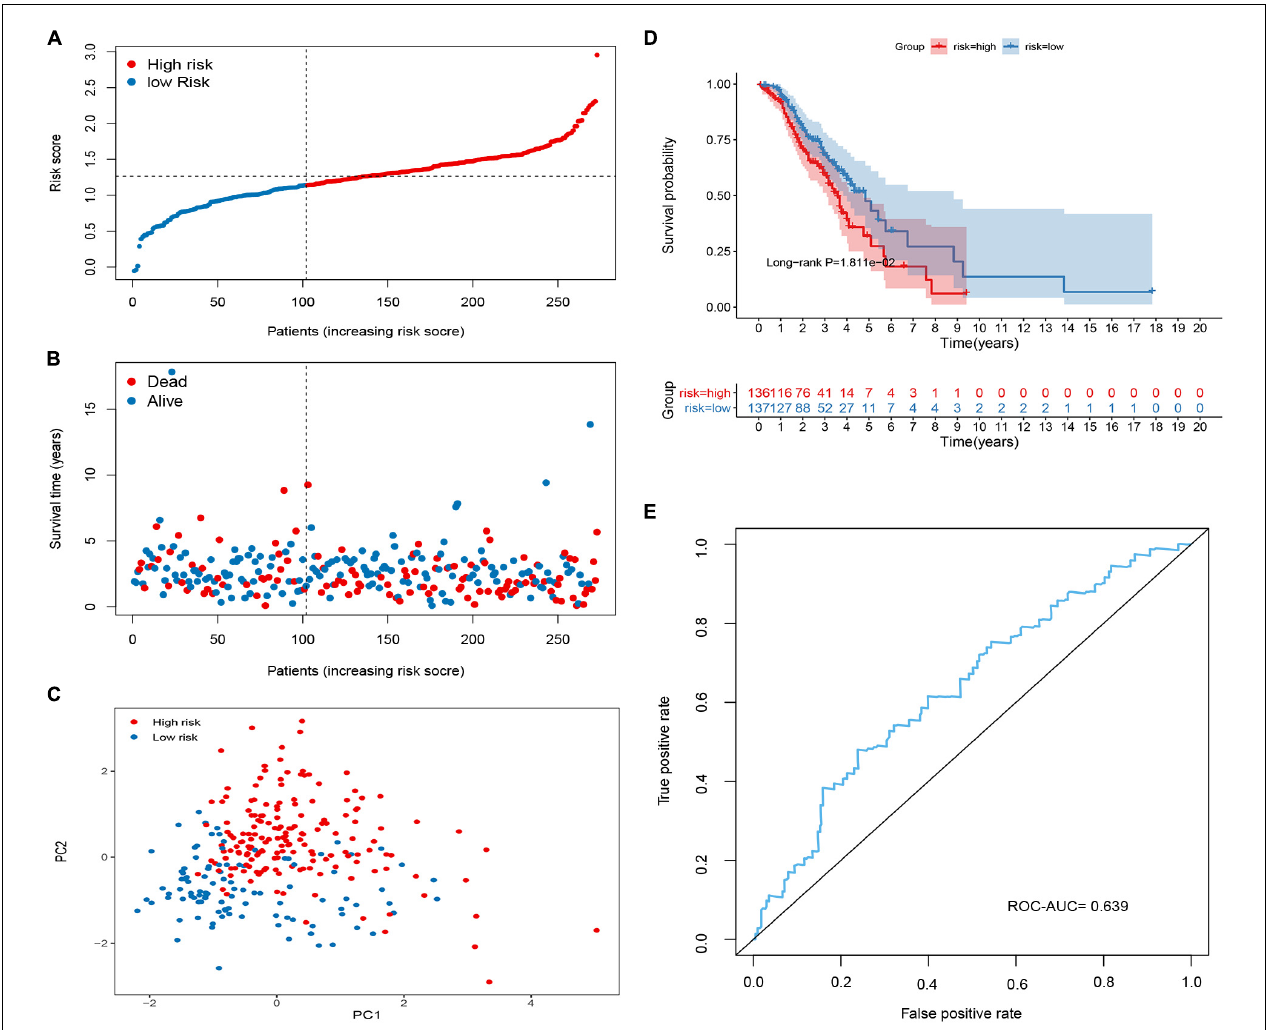
FIGURE 4 | Validation of the methylated related gene signature in the GSE9891 cohort. (A) Dot plot of risk score. Y axis represents risk score. Red and blue color dots represent, respectively, high and low risk score samples. (B) Dot plot of survival. Y axis represents survival times (years). Red and blue color dots represent, respectively, dead and living OC samples. (C) PCA plot of the GSE9891 cohort. (D) KM estimate of the OS in the GSE9891 cohort. (E) The time-dependent ROC curves in the GSE9891